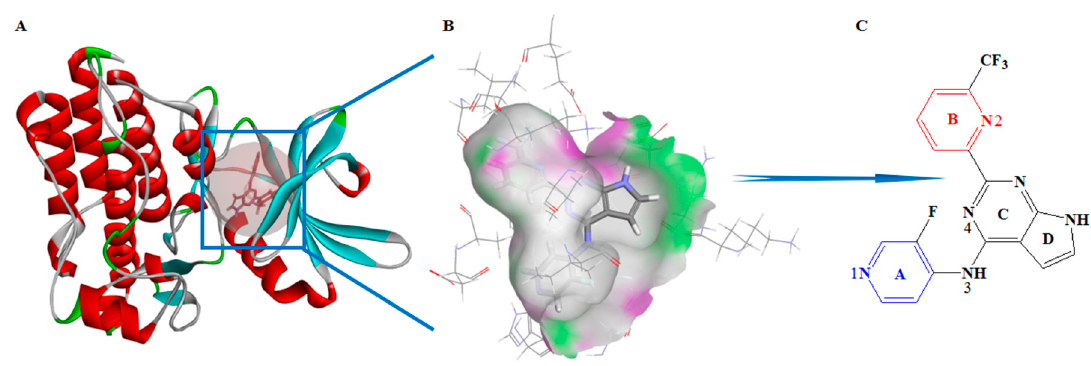
Figure 1. ( A ) Crystal structure of complex (Protein Data Bank (PDB) ID: 6B8Y), ( B ) receptor surface of H-bond, and ( C ) structure of BMS22, of which four rings are labeled A, B, C and D, and four key nitrogen atoms are specified as 1, 2, 3, and 4.